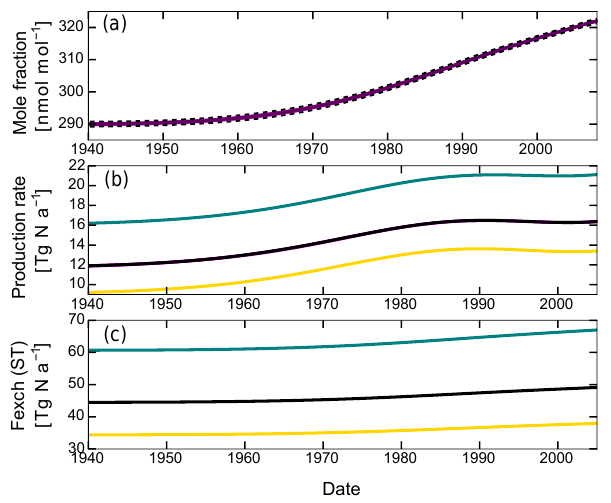
Figure D3. (a) N 2 O mole fraction history constrained with the most precise data at NEEM only to narrow the uncertainties (solid black line with uncertainty envelopes as dashed black lines) and the sce- narios within the uncertainty envelopes that were used in the mass balance model (magenta lines) to evaluate the uncertainties of the atmospheric modeling results. (b) N 2 O production rate as calcu- lated from the mass balance model assuming a high (0.28Tmols − 1 ) F exch in light green and a low (0.16Tmols − 1 ) value in yellow. The solid black line represents the result for the best-fit reconstruction, while magenta lines represent the results for the individual scenarios from the top panel as used in the main paper. (c) N 2 O flux exchange results between stratosphere and troposphere as calculated from the mass balance model assuming a high (0.28Tmols − 1 ) F exch in light green and a low (0.16Tmols − 1 ) value in yellow. The solid black line represents the result for the best-fit reconstruction as used in the main paper.